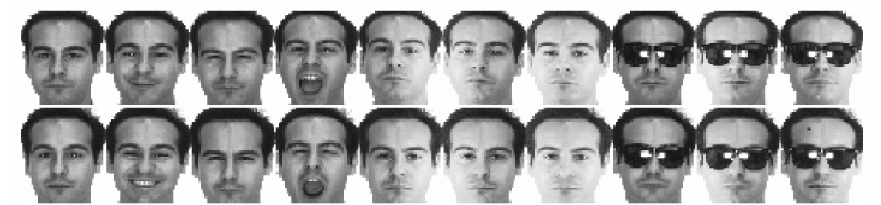
Figure 9. Facial image of an individual in the AR face database.